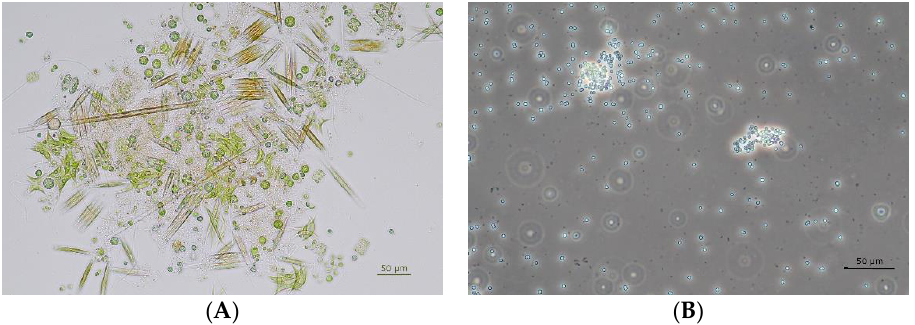
Figure 3. Microscopic control of phtoto-autotrophically cultivated samples from the fire-pond at IFA-Tulln (AUT); ( A ) original mixed culture enriched in BG-I mineral medium (bright field image) and ( B ) after cultivation in presence of cycloheximide (phase contrast image).